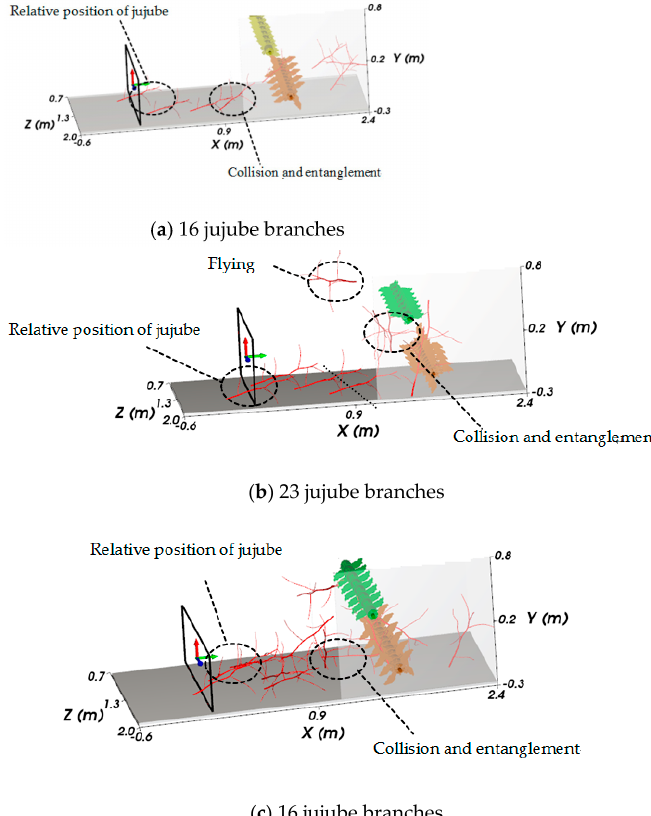
Figure 8 . Effect of the total number of jujube branches fed on the movement position of jujube branches .